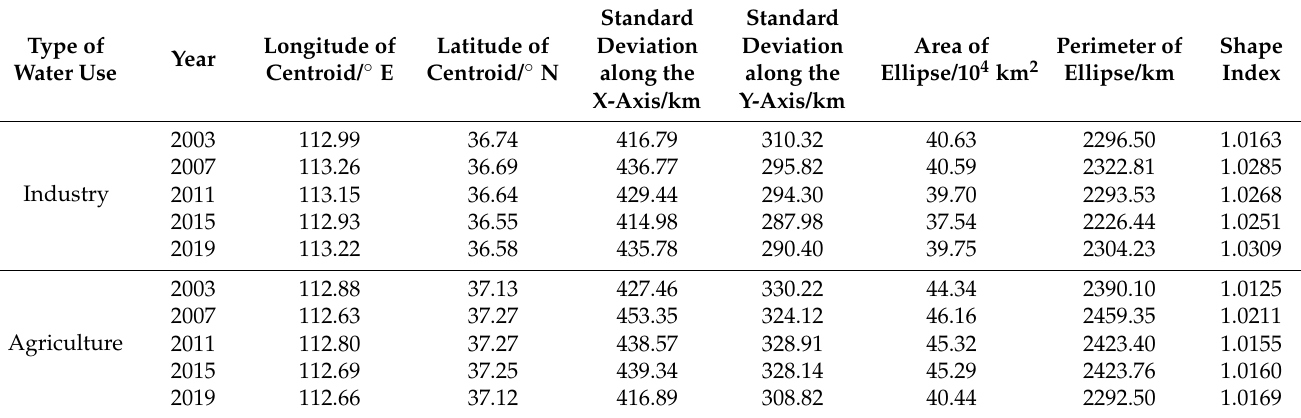
Table 3. Changes in center of gravity and standard deviational ellipse of water use